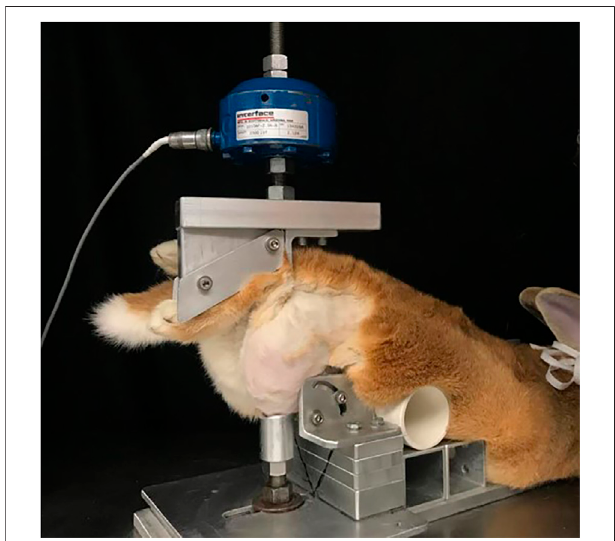
FIGURE 1 | Injurious impact of rabbit knee set-up. In prone position (belly down) the rabbit ’ s hind paw was supported directly below the actuator of a servo-hydraulic machine. The knee was supported to prevent lateral and medial motion (with permission from Narez et al.,